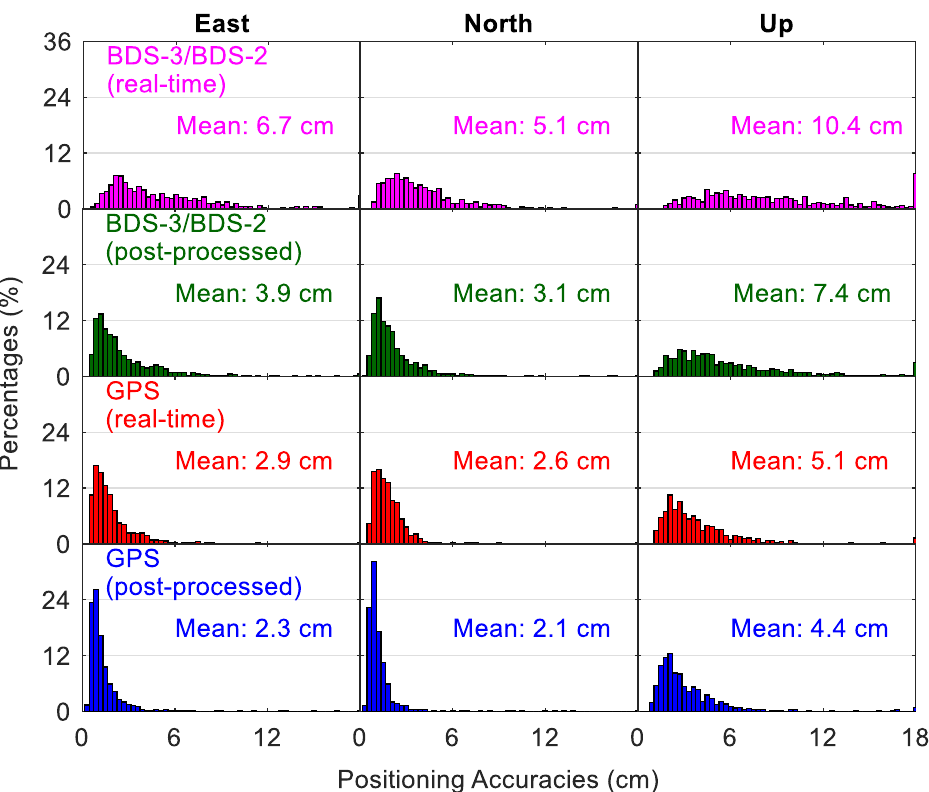
Figure 16. Distribution of positioning accuracies from different kinematic PPP solutions.